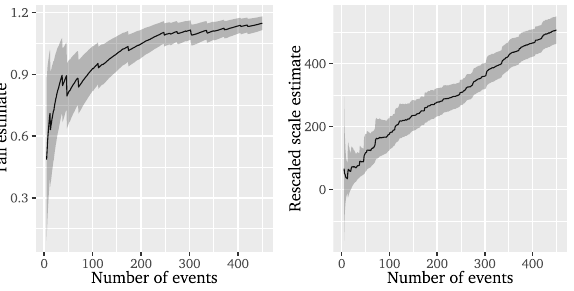
Figure 7. Mittag–Leffler parameter stability plots for the inter-event